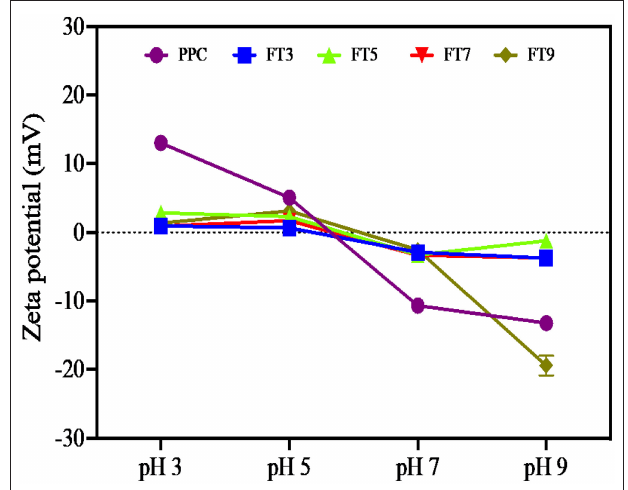
FIGURE 1 | Surface charge of the native protein (PPC) and isolated fractions at pH 3.0, 5.0, 7.0, and 9.0. measured as the zeta potential (mV). PPC was heated at 100 ◦ C and varying pH, centrifuged, and the supernatant passed consecutively through 30 and 50 kDa membranes. The final retentate from the 50 kDa membrane was collected as FT3, FT5, FT7, and FT9 for heat treatments at pH 3.0, 5.0, 7.0, and 9.0, respectively.